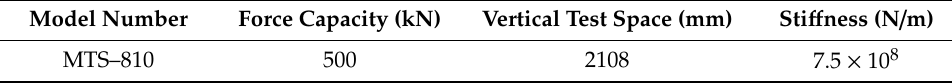
Table 5. Technical specifications of the compression test machine.